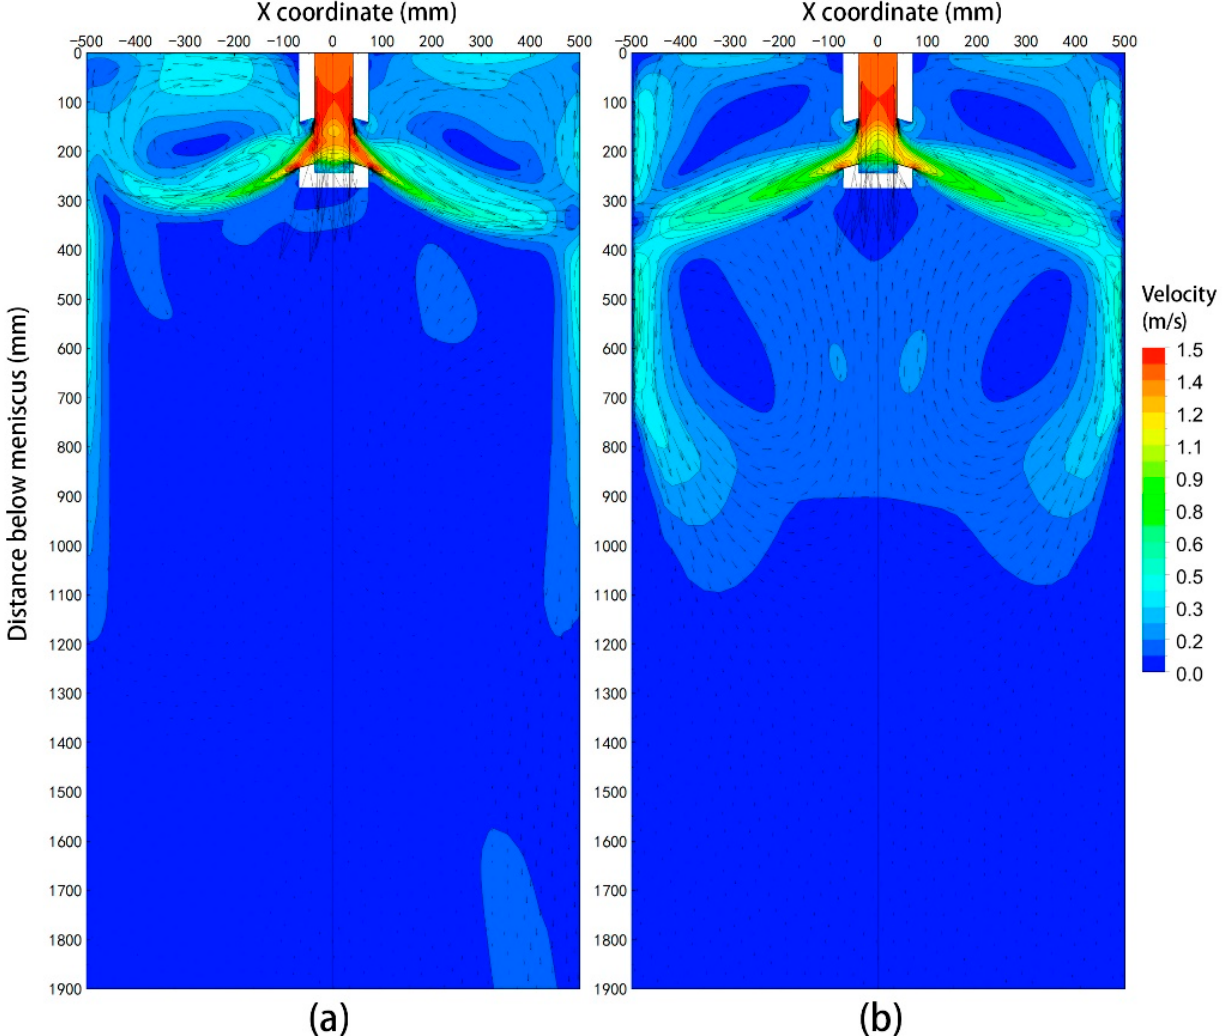
Figure 7. Velocity distribution and contours profiles in Y = 0 plane: ( a ) without solidification model; ( b ) with solidification model.